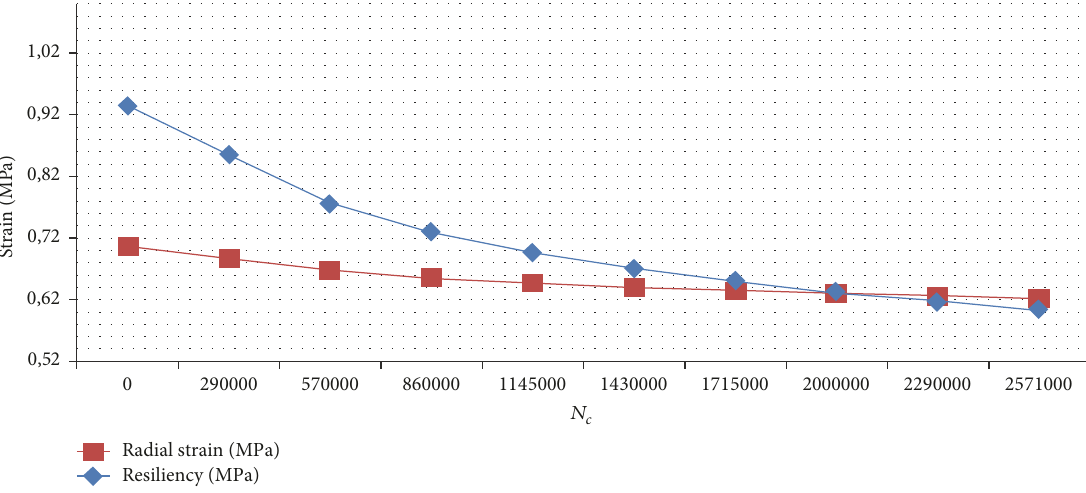
adjustable within constraints of the pavement length. Radial strains at the bottom edge of surfacing arise as a combination of surfacing deflection under the loading unit and acceler- ation and deceleration forces on the tire-pavement contact area. APT facility parameters are listed in Tables 5 and